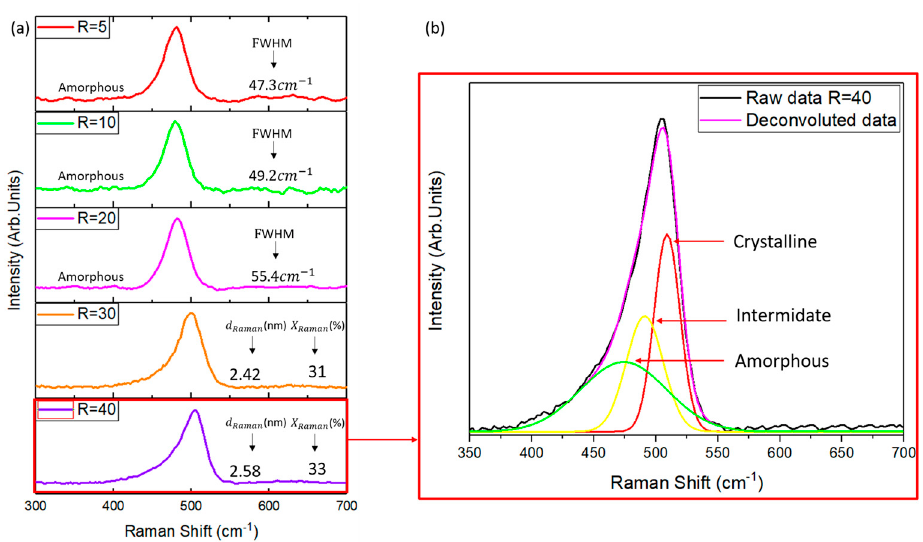
Figure 5. ( a ) Raman spectra of PECVD deposited nc-Si:H films; ( b ) Gaussian de-convoluted Raman spectra at hydrogen dilution ratio ( R = 40).